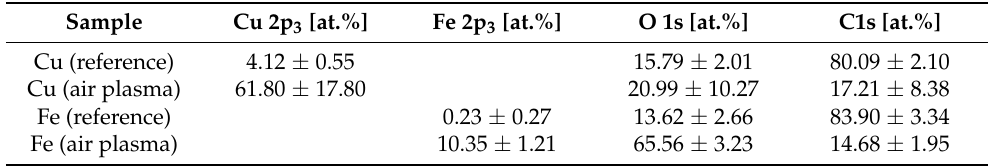
Table 2. Composition of the metal strips before and after low-pressure plasma treatment with ambient air for 60 min. These data were obtained from XPS measurements.